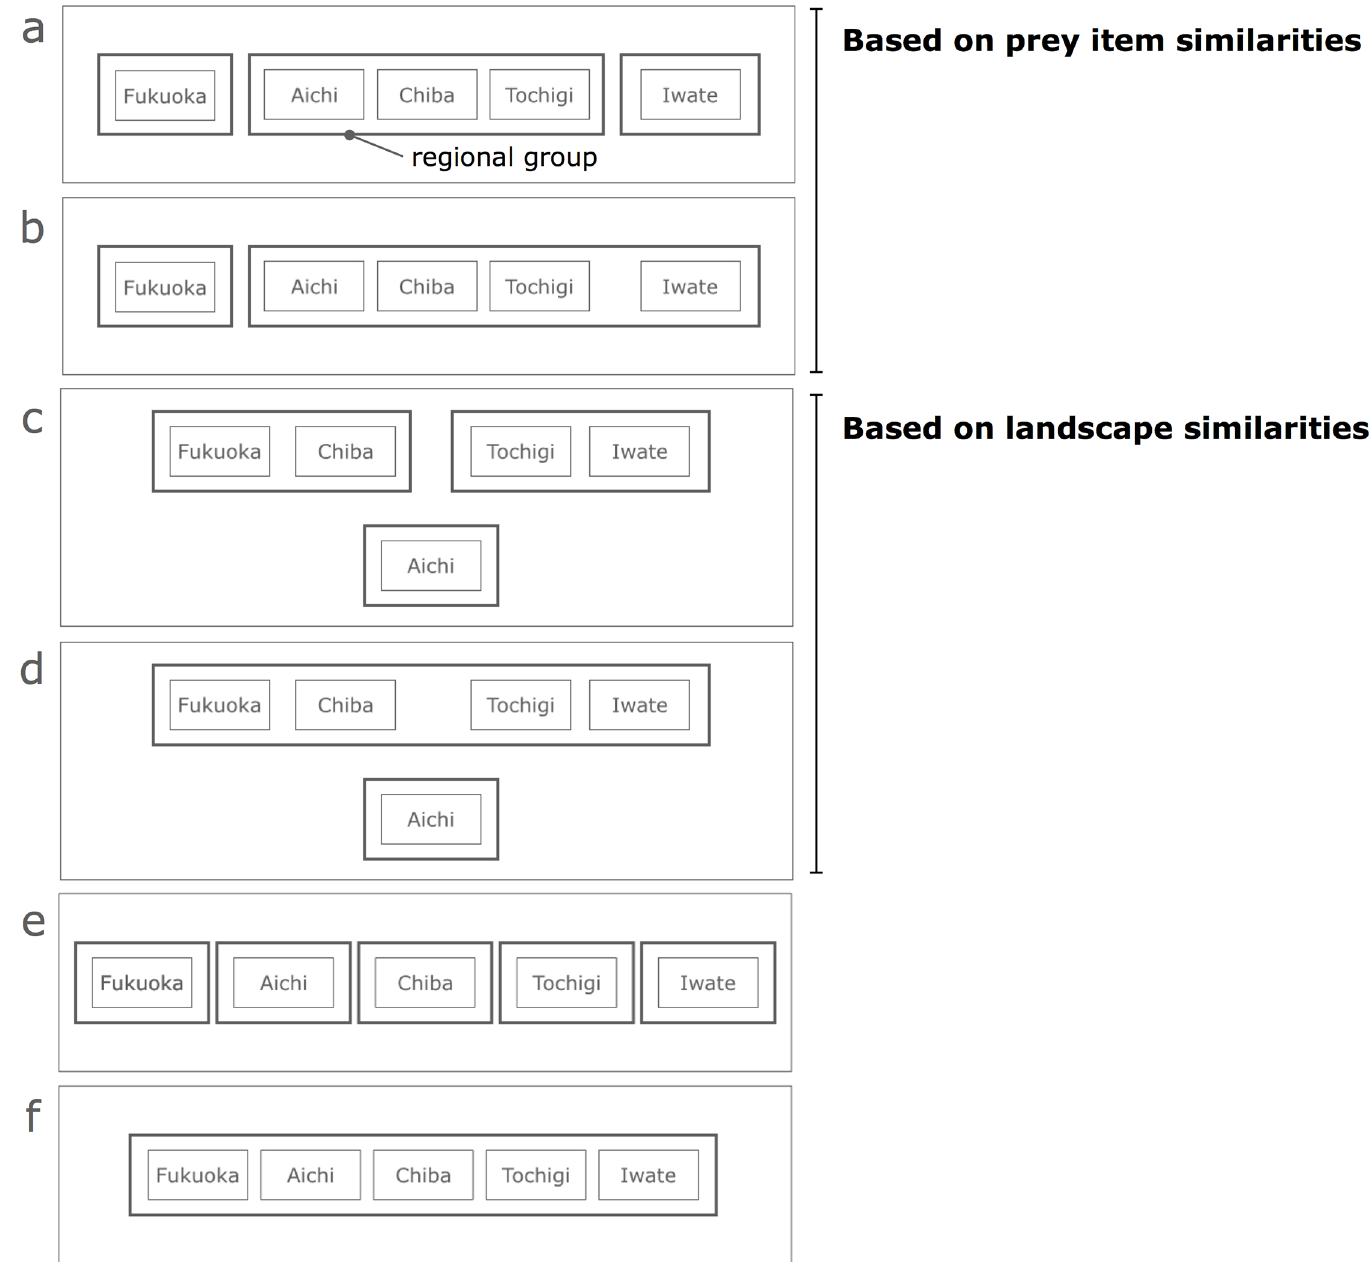
Fig 3. Schematic diagram representing six hypotheses to stratify five study-sites based on prey-item similarities (a, b), landscape-composition similarities (c, d), and others (e, f). a: 3 regional groups hypothesis based on prey item similarities, b: 2 regional group hypothesis based on prey item similarities, c: 3 regional group hypothesis based on landscape similarities, d: 2 regional group hypothesis based on landscape similarities, e: 5 regional group hypothesis, f: single regional group